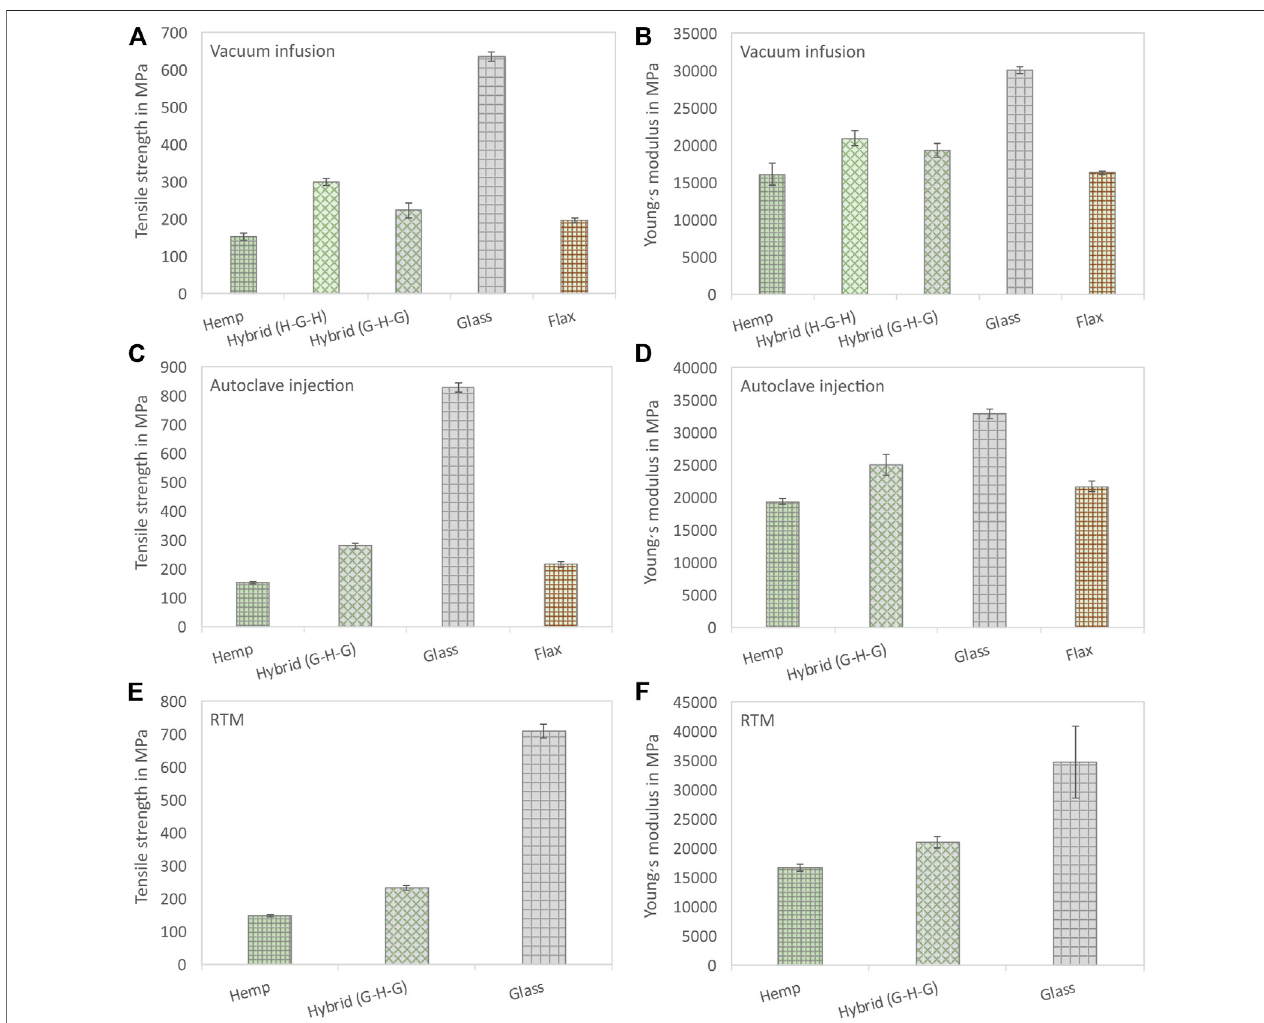
FIGURE 7 | Tensile strength and Young´s modulus (mean value ± standard deviation) of composite laminates produced by vacuum infusion (A,B) , autoclave injection (C,D) and RTM (E,F) .